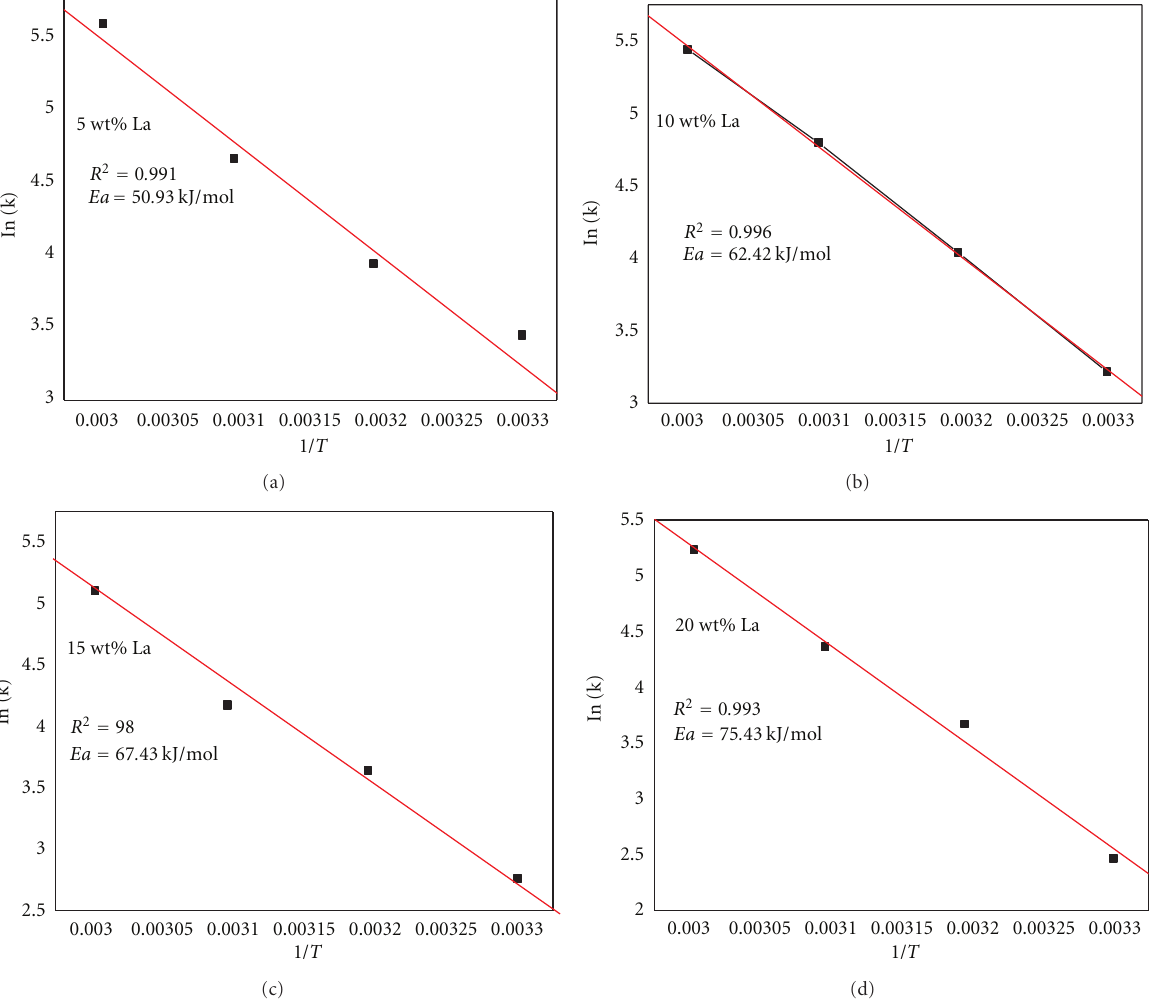
Figure 5: Arrhenius plot of the rate constants using Al- x wt% La-5wt% NiCl 2 /NaBH 4 (Al-La-NiCl 2 /NaBH 4 weight ratio, 1:1). x : 5, 10, 15 and 20 wt%.